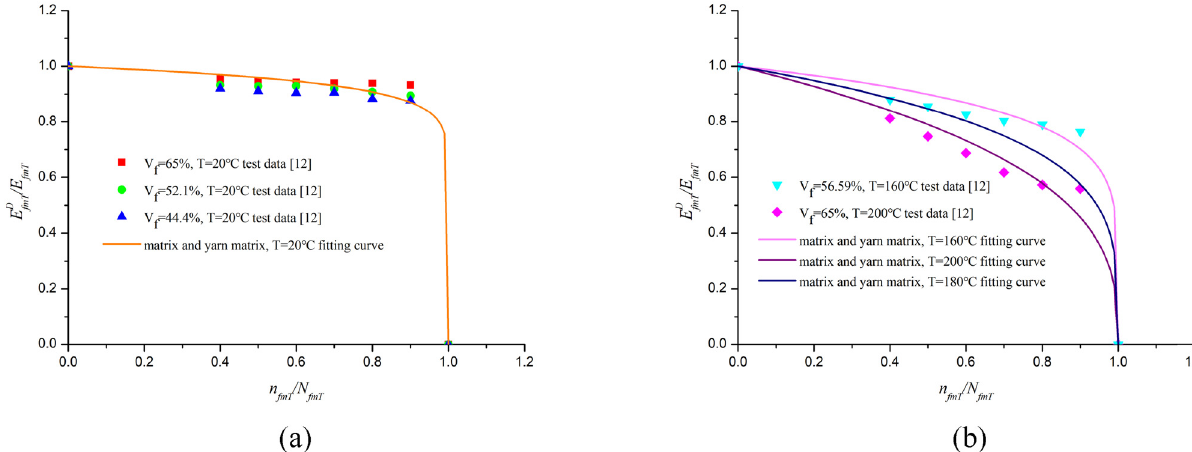
Figure 8: The fi tting curve of the normalized residual sti ff ness vs the normalized fatigue life of [± 45 ] n cross - ply laminates at ( a ) 20°C and ( b ) 180°C.